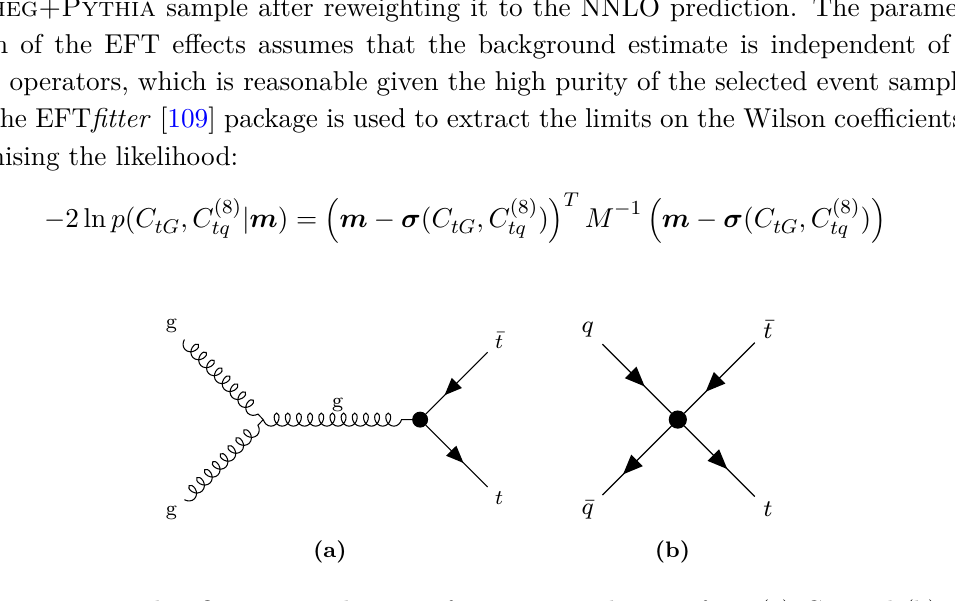
Figure 18. Example LO Feynman diagrams for EFT contributions from (a) C Couplings affected by EFT contributions are marked by the black